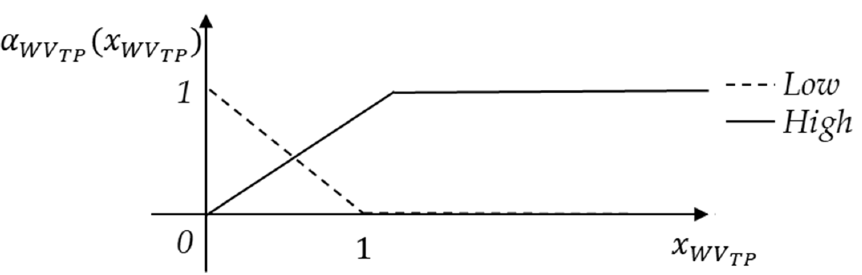
Figure 6. The membership function of the linguistic variable irregularity of workstation load.